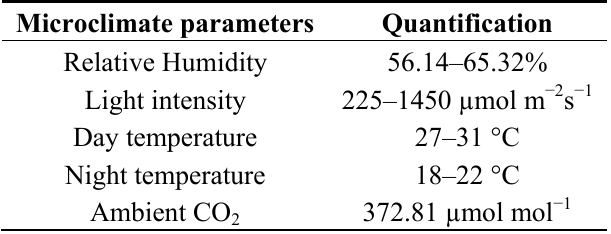
Table 6. Microclimatic condition under the research area during 12 weeks of